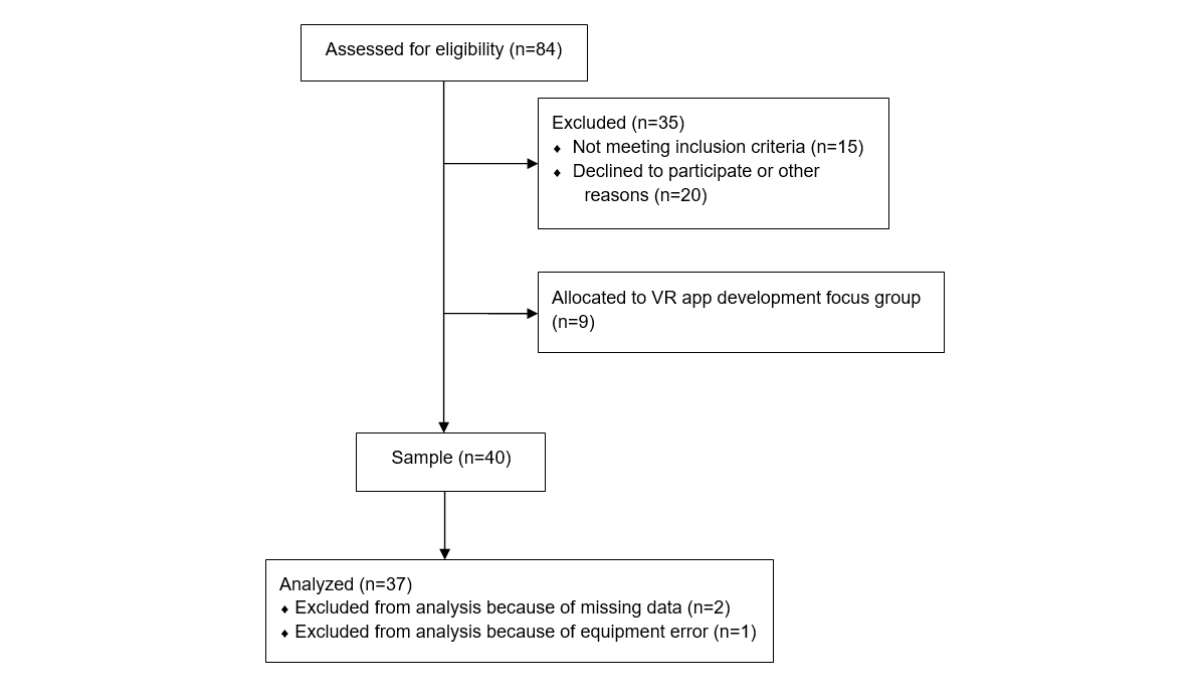
Figure 2. Flowchart illustrating participant recruitment to data analysis. VR: virtual